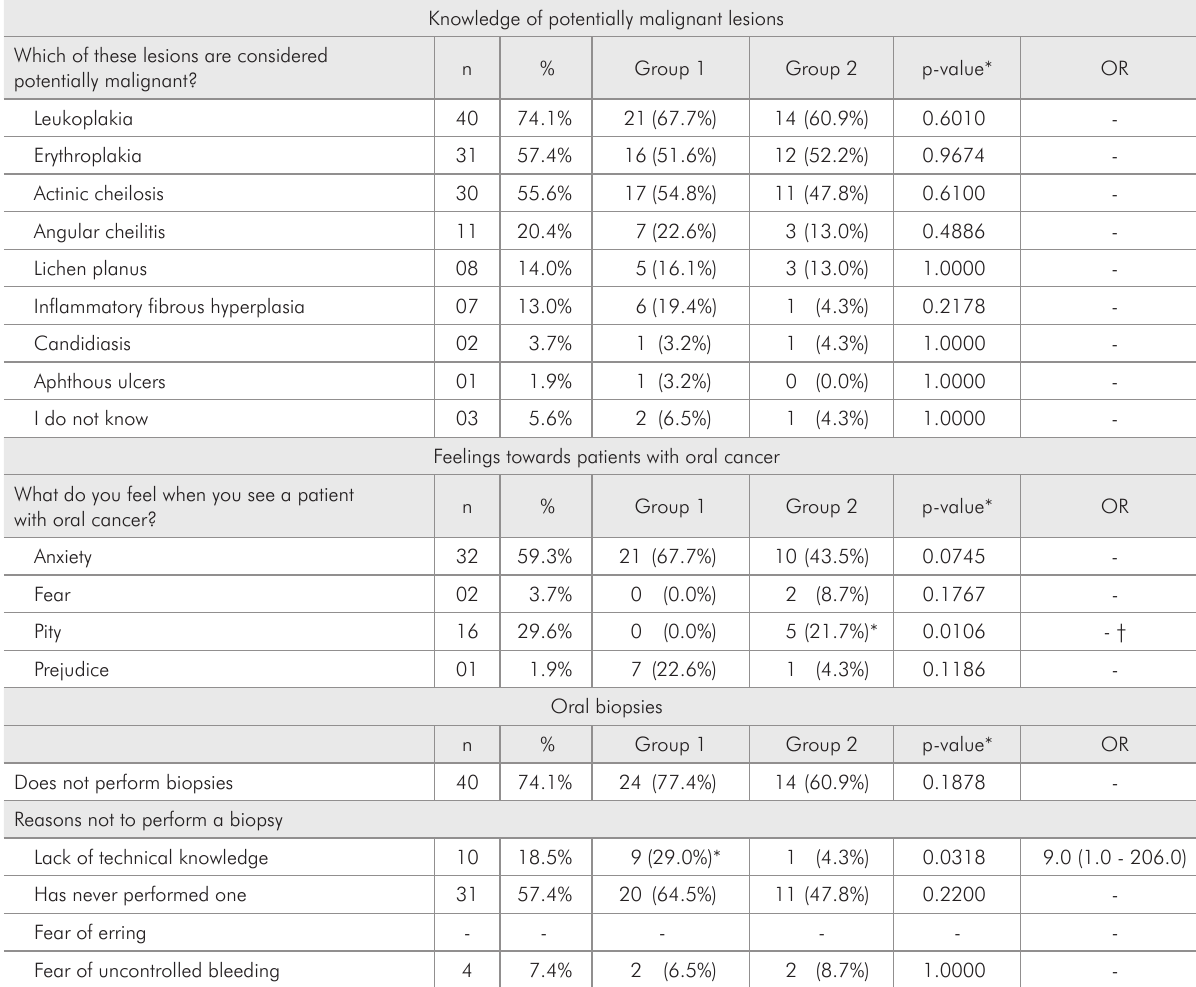
Table 4 - Dentists’ knowledge of potentially malignant lesions, feelings towards patients with oral cancer, and reasons for their perceived inability to perform biopsies by